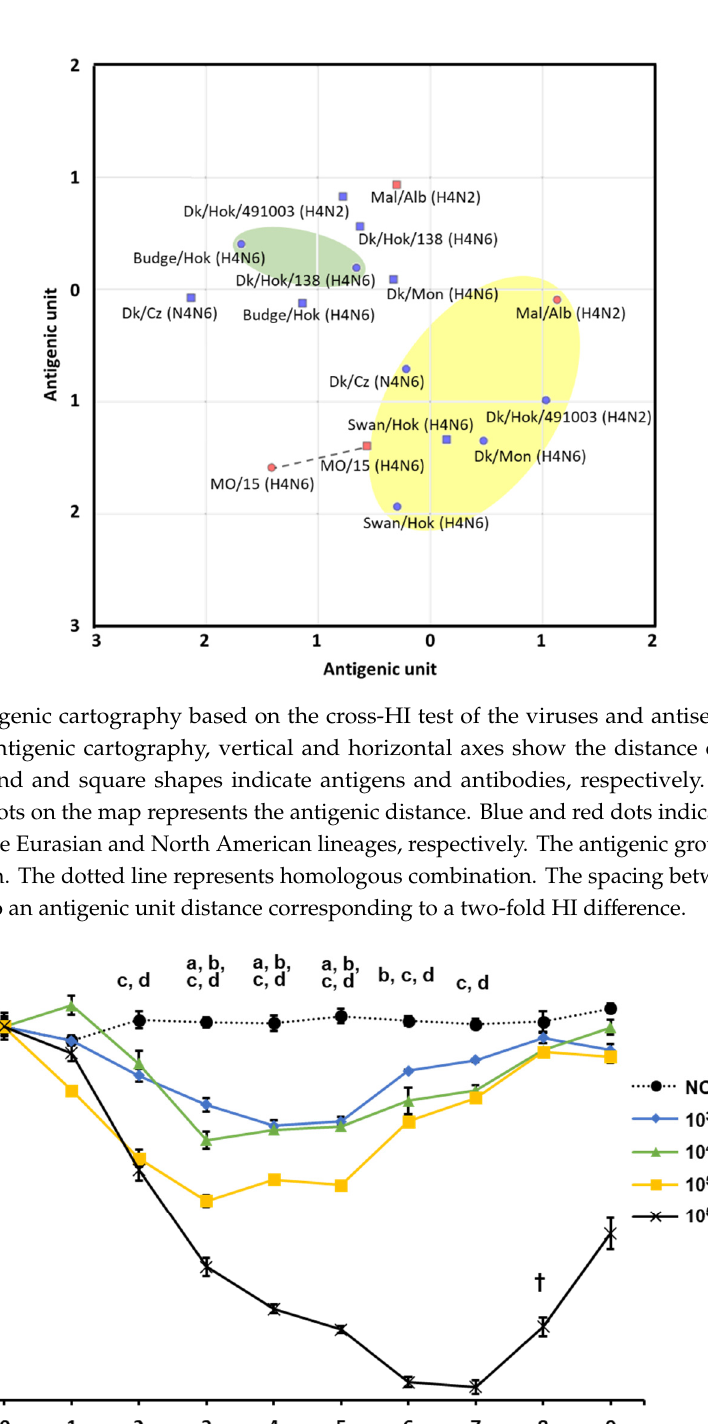
Figure 3. Changes in the body weight of mice inoculated with various doses of MO / 15 influenza virus. The pathogenicity of dose-dependent viral titers was compared. Body weight was monitored for 9 days after challenge with di ff erent doses (10 3.0 , 10 4.0 , 10 5.0 , or 10 5.9 plaque-forming units (PFU) / 30 µ L) of MO / 15 ( n = 4 mice / group). † , euthanasia. a, significant di ff erence between NC and 10 3.0 PFU / head ( p < 0.05); b, significant di ff erence between negative control (NC) and 10 4.0 PFU / head ( p < 0.05); c, significant di ff erence between NC and 10 5.0 PFU / head ( p < 0.05); d, significant di ff erence between NC and 10 5.9 PFU / head ( p < 0.05).